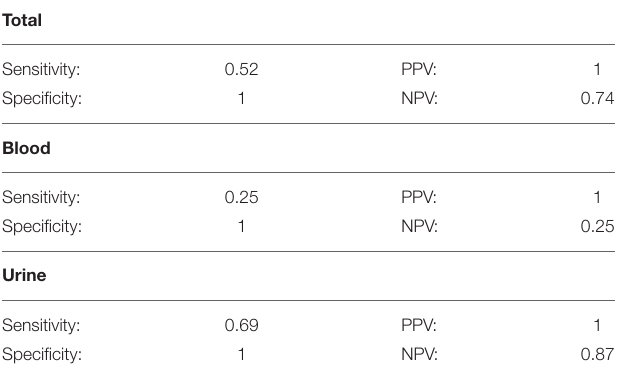
TABLE 2 | Sensitivity, specificity, positive predictive value (PPV), and negative predictive value (NPV) for the PCR assay in total, from blood alone, and from urine alone in dogs of this